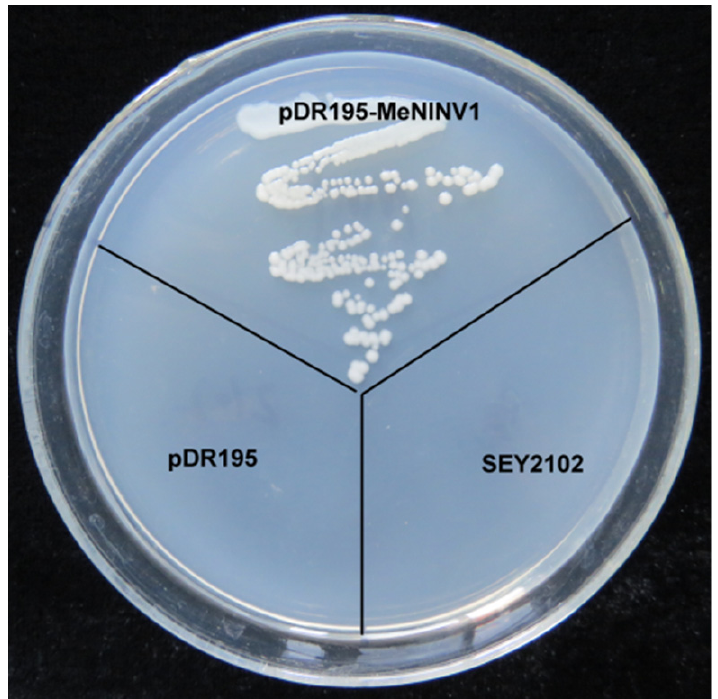
Figure 1. Invertase activity analysis of MeNINV1 in transgenic yeast cells. pDR195-MeNINV1: SEY2102 was transformed with pDR195-MeNINV1; pDR195: SEY2102 was transformed with pDR195; SEY2102: the invertase mutant SEY2102. Yeast cells were grown on SD medium with sucrose as the sole carbon source at 30 °C for 3 d.